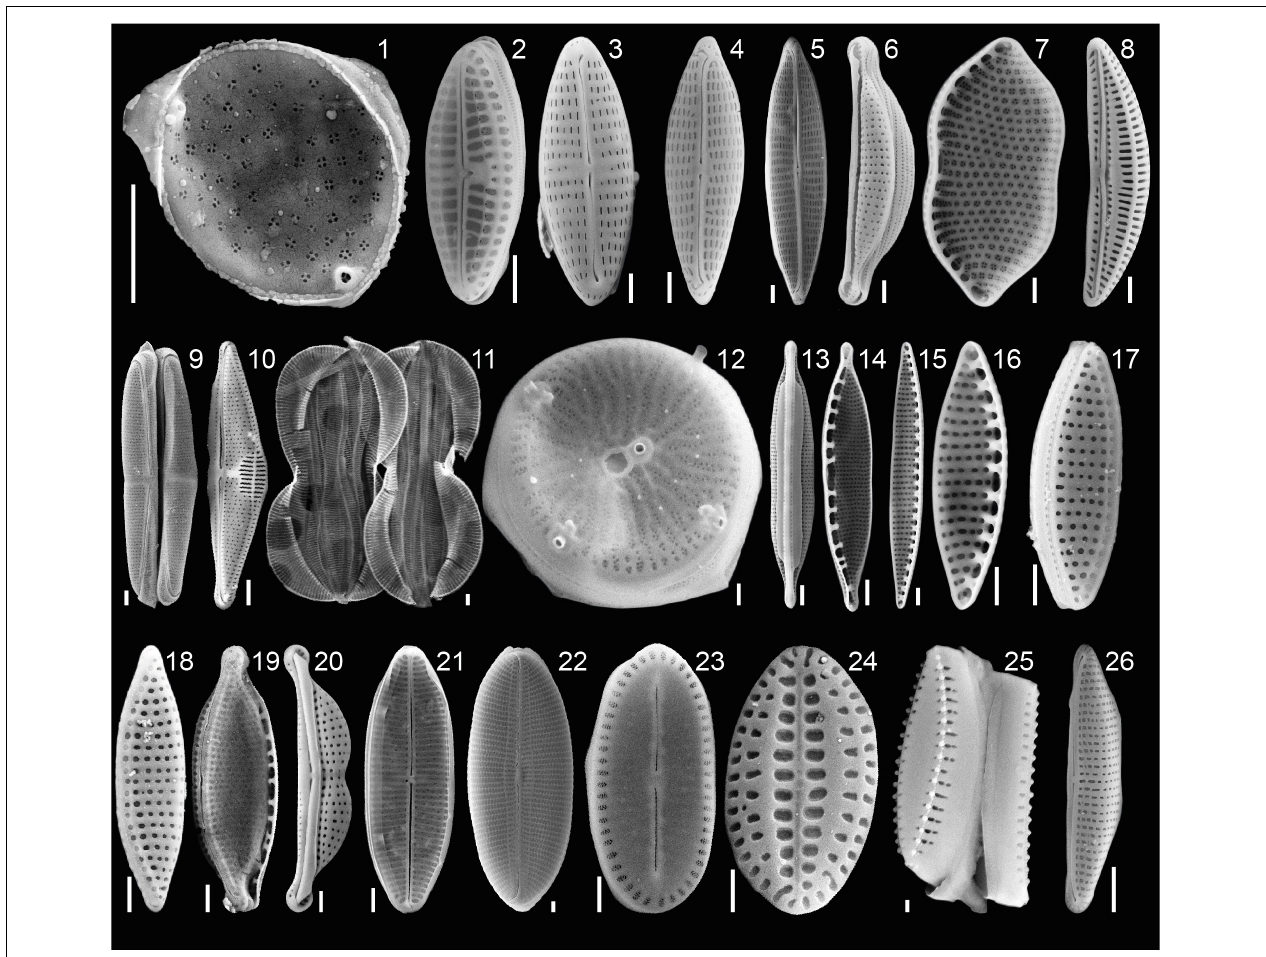
FIGURE 4 | Plate of isolated endosymbiotic diatoms from the benthic foraminifera P. calcariformata, specimens ordered by total abundance over all isolations in this study. Scale bar 1 µ m, 1, Minutocellus polymorphus ; 2, Olifantiella pseudobiremis ; 3, Navicula sp., 4, Navicula cf. salinicola ; 5, Navicula duerrenbergiana ; 6, Halamphora subsalina ; 7, Tryblionella coarctata f. densestriata ; 8, Amphora inariensis ; 9, Amphora jostesorum ; 10, Amphora pseudoeximia ; 11, Entomoneis paludosa ; 12, Minidiscus sp., 13, Nitzschia sp.; 14–18, Nitzshia frustulum var. symbiotica ; 19, Nitzschia microcephala ; 20, Halamphora kolbeii ; 21, Astartiella punctifera ; 22, Diploneis sp.; 23, Cocconeis sp.; 24, Amphicocconeis sp.; 25, Pseudostaurosira sp.; 26, Cymbella sp. For taxonomic references please see section “Materials and